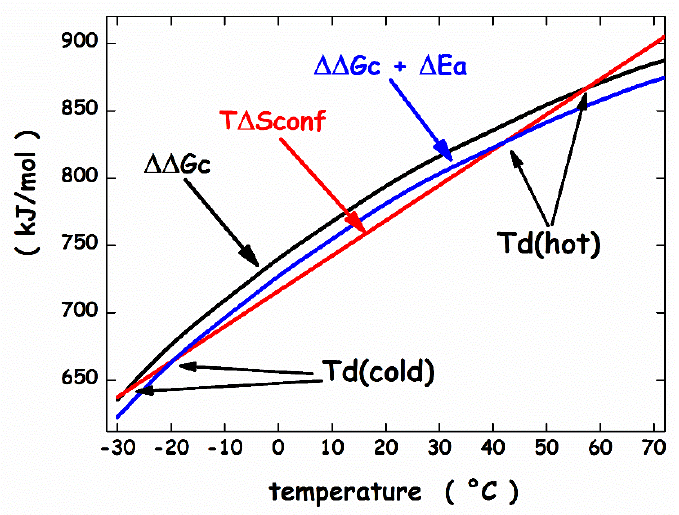
Figure 5. Temperature dependence of the functions, ∆ G c , ∆∆ G c + ∆ E a , and T · ∆ S conf , calculated as described in the